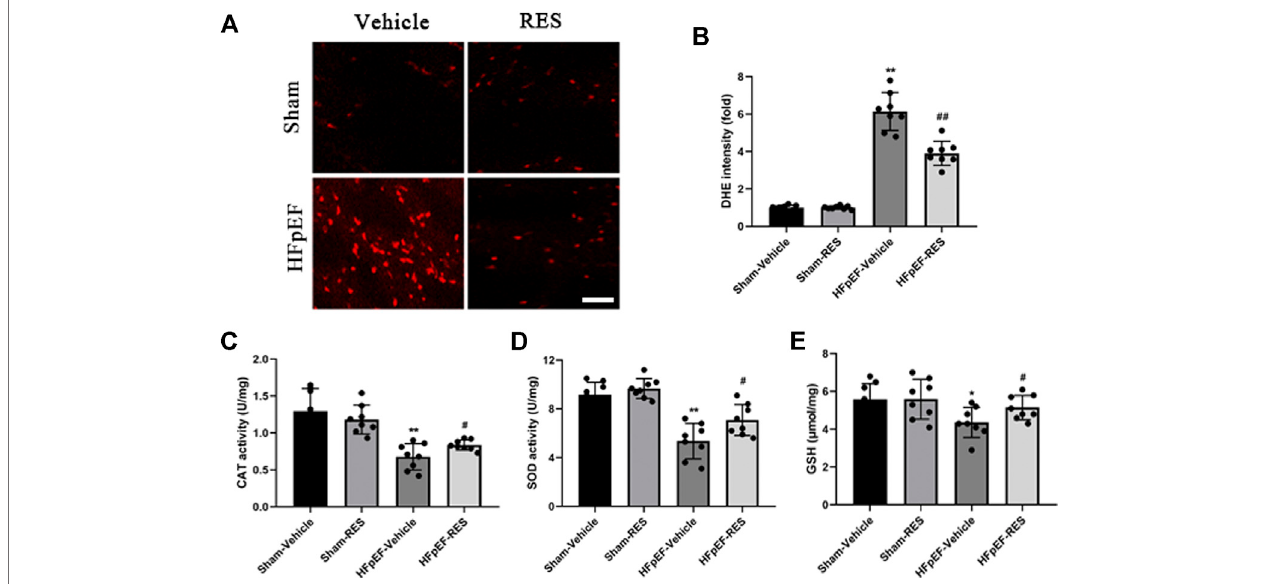
FIGURE 5 | Effect of RES on HFpEF-induced oxidative stress. (A) Representative images and (B) quantitative results of DHE-stained heart sections ( n (cid:2) 8 per group). (C) ActivitiesofCATafterREStreatment( n (cid:2) 8pergroup). (D) ActivitiesofSODafterREStreatment( n (cid:2) 8pergroup). (E) ContentofGSHafterREStreatment( n (cid:2) 8 per group). * p < 0.05 vs. sham-vehicle group. ** p < 0.01 vs. sham-vehicle group. # p < 0.05 vs. HFpEF-vehicle group. Scale bars, 50 µm.